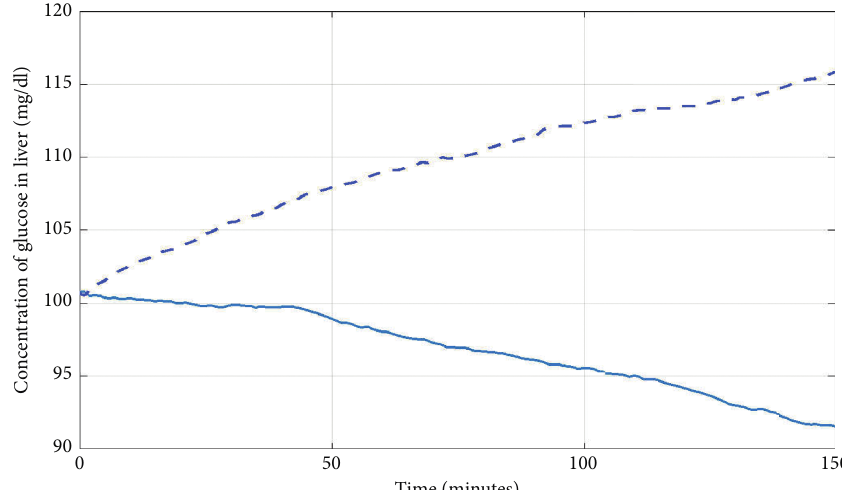
Figure 8: Hepatic glucose profile during euglycemic hyperinsulinemic clamp test. The dashed line shows the type 2 diabetic patients hyperglycemic clamp test, while the solid line shows the same for healthy